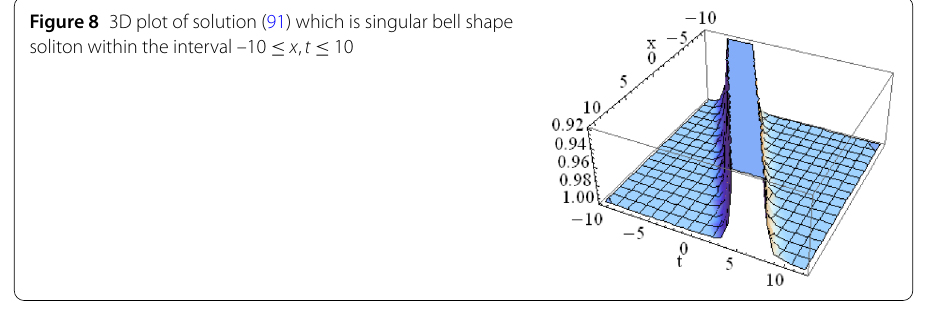
Figure 9 3D plot of singular kink wave of solution (93) within the interval –8 ≤ x ≤ 8, –10 ≤ t ≤